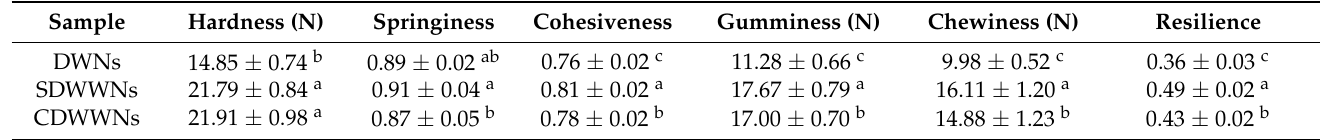
Table 3. Total texture properties of three kinds of dried